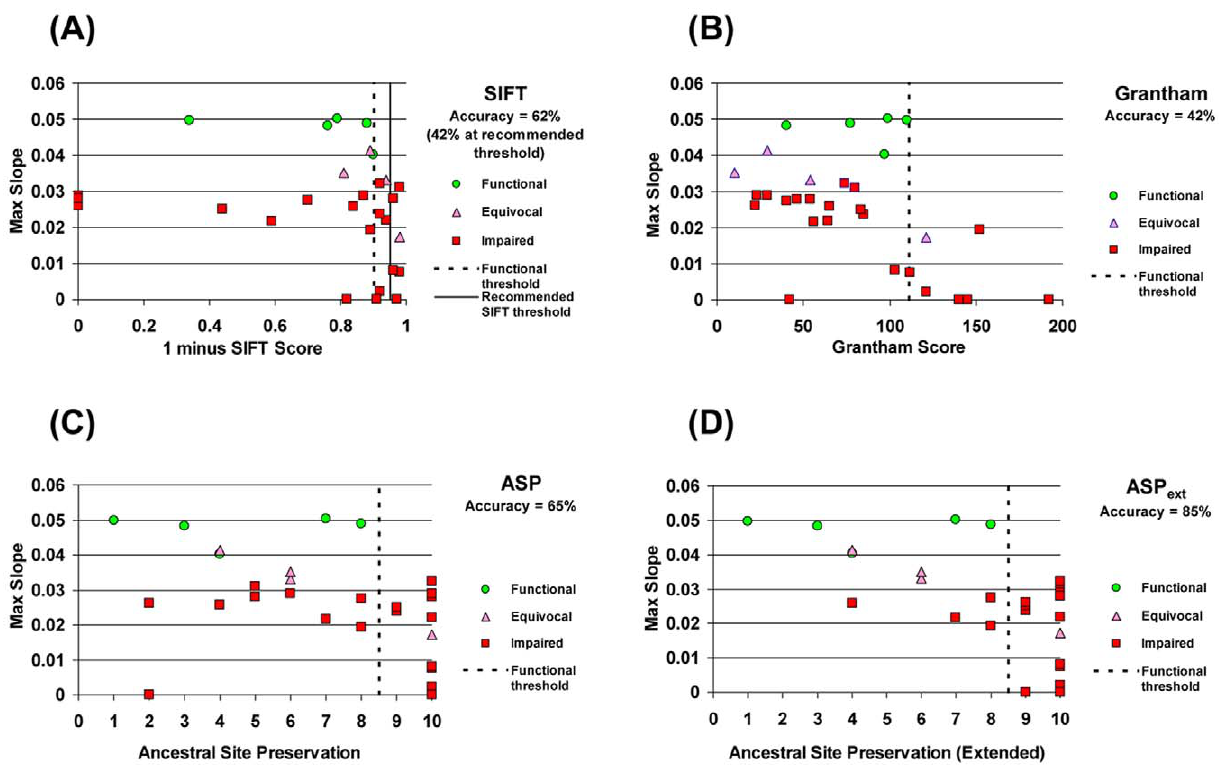
Figure 4. Accuracy of discrimination between functional and impaired variants by different methods. Growth-rate metrics for the 30 variants in Table 1 plotted against scores/classifications from various methods that estimate functional impact. The accuracy of each method was determined by calculating the number of mutations correctly called as functional or impaired divided by the number of mutations unambiguously classified by experimental data. Binning of mutations was determined by using a threshold empirically defined by the functional alleles (dashed vertical line in each panel) to define the functional (left of line) and impaired (right of line) bins. (A) SIFT score; note that the graph plots (1–score) to facilitate comparison with the other methods. All functional variants have a SIFT score . 0.09 which, when used as a threshold results in a classification accuracy of 62%. The recommended threshold of 0.05 (solid vertical line) results in a lower classification accuracy (42%). (B) Grantham scale of amino acid dissimilarity between wild-type and substituted amino acid. (C) Ancestral Site Preservation (ASP) measure, using inferred ancestral sequences of human MTHFR. Numbers on the x-axis correspond to increasingly ancient ancestors of human MTHFR as defined by the nodes in Figure 3. (D) Ancestral Site Preservation Extended (ASP ext ) measure. If a site was preserved in the ancestral lineage for a long period before being substituted by the current-day amino acid, the more ancient ancestor is used to define preservation at this site. The preservation measure for 5 variants is shifted by this criterion (see Table